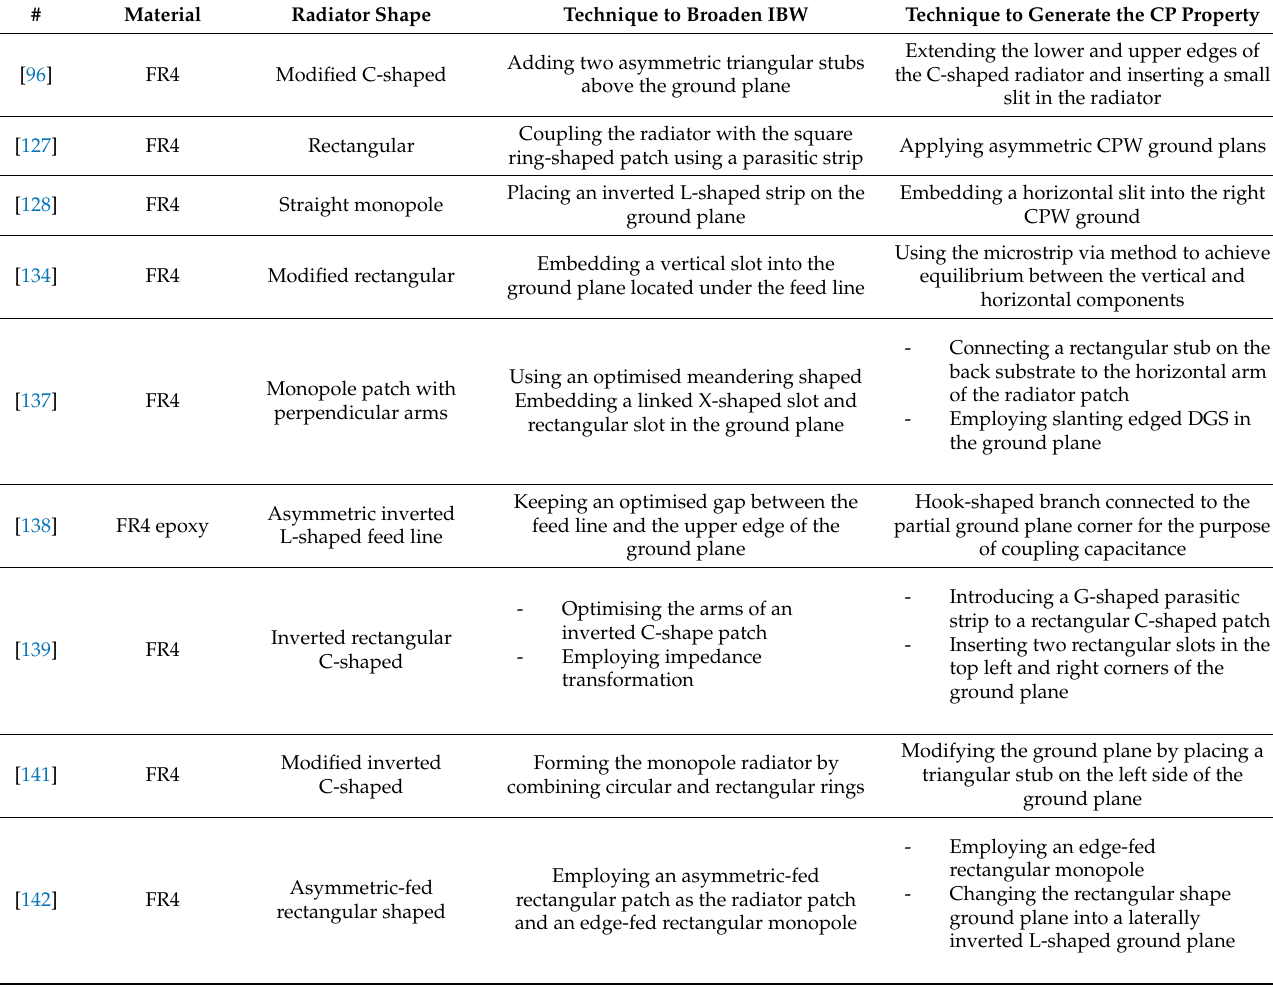
Table 4. Summary of the Broadband CP Printed Monopole Antennas (BCPPMAs) from the